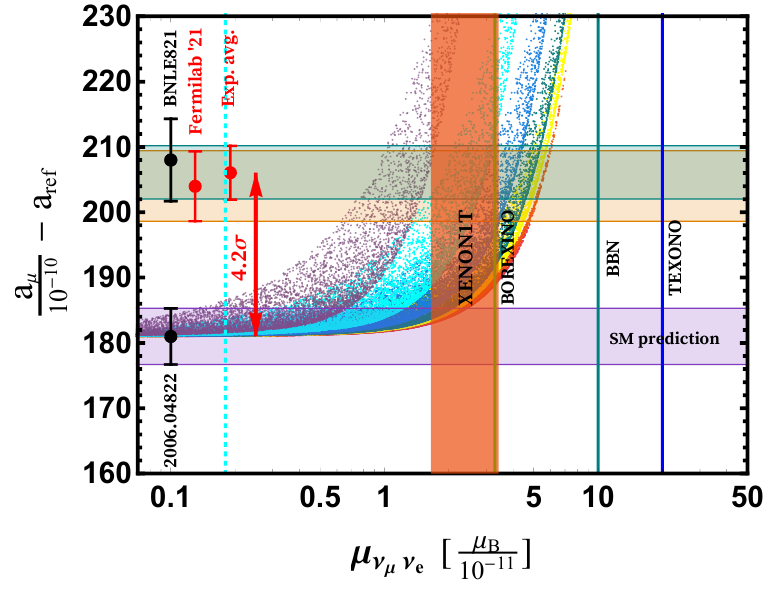
Figure 4 . Theoretical predictions and experimental measurements of the muon anomalous mag- netic moment and the neutrino transition magnetic moment. Purple, cyan, light blue, blue, green, yellow, orange and red scattered points depict the correlated predictions for the muon magnetic moment ( a µ ) and neutrino magnetic moment ( µ ν ) in our framework for different ranges of mass µ ν e splittings between the charged scalars: m − m = 20 , 50 , 100 , 200 , 300 , 500 , 800 and 1000 GeV. H + h + Here we choose different ranges of parameters as { f 0 ∈ (0 . 001 − 1) , m ∈ (45 − 500) GeV, and φ 0 m − m ∈ (20 GeV–1 TeV) } consistent with the theoretical and experimental limits discussed H + h + in text. The lower black dotted point with error bar indicates the updated SM prediction [2] for a µ (see other previous analyses (in chronological order) as: HMNT06 [29], DHMZ10 [30], JS11 [31], HLMNT11 [32], DHMZ17 [33], KNT18 [34]) , and others [35–51]). The upper dotted data points with error bars represent different experimental measurements: BNLE821 [1], Fermilab [3], and the combined experimental average of the BNL [1] and Fermilab [3] results. These evaluations and mea- surements of a µ are independent of neutrino magnetic moment values. The current uncertainty on the measurement of a µ at the Fermilab [3] is given by the light brown band at 1 σ level. The purple band represents the SM prediction from ref. [2] with 1 σ value and the light green band indicates the combined experimental average of the BNL [1] and Fermilab [3] results at 1 σ level. Here we choose the reference value a ref = 11659000 . The orange band labelled with XENON1T denotes the preferred range µ ν ∈ (1 . 65 − 3 . 42) × 10 − 11 µ B to explain the electron recoil excess at 90% C.L [4]. e ν µ The vertical lines indicate the limits on neutrino magnetic moment from various measurements: blue solid line from TEXONO [52], dark green solid line from BBN [53], light green solid line from BOREXINO [11], and cyan dashed line from globular clusters [20]. The astrophysical limits on neutrino magnetic moment shown by the dashed cyan line can be evaded by utilizing a neutrino trapping mechanism [5] (see discussions in